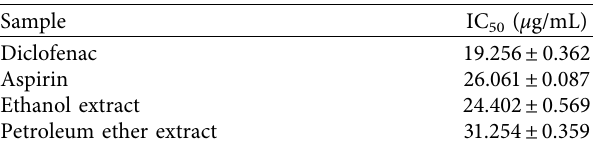
Figure 7: Anti-infammatory action of ethanol and petroleum ether extracts of C. nioroense [27]. Table 8: IC 50 of anti-infammatory activity of extracts of C. nioroense .